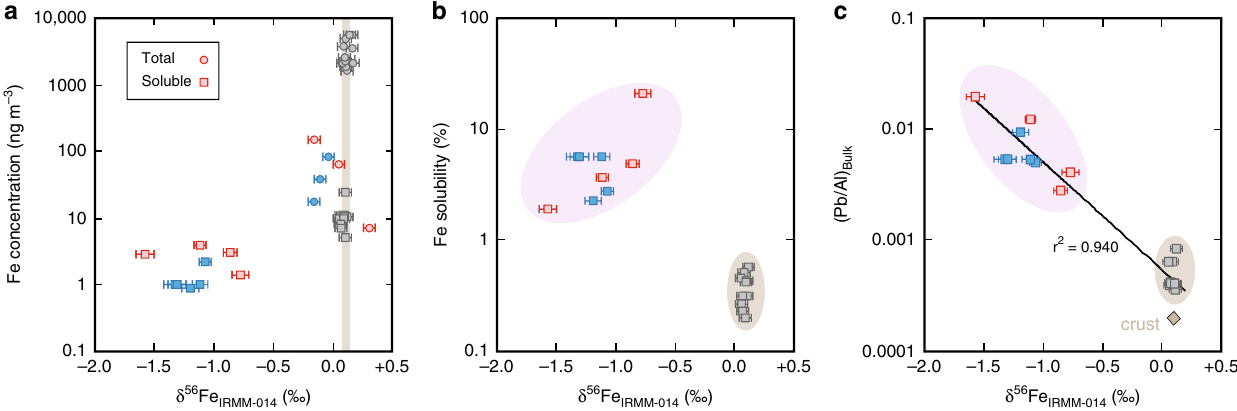
Fig. 2 North Atlantic GA03 aerosol Fe isotope results. Water-soluble and bulk aerosol δ 56 Fe relative to a Fe concentration 43 , b Fe solubility 44,45,58 , or c bulk Pb/Al 43 . Aerosols from different air masses 43 are separated by color: gray Saharan (2010 and 2011), red European (2010), and blue North American (2011). Error bars on δ 56 Fe are 2 σ external error (0.05 ‰ ) or 2 σ internal error (where larger). The brown vertical bar represents the δ 56 Fe signature of crustal source materials (0.07 – 0.14 ‰ ) 32 . Circles denote natural crustal (brown) or anthropogenic-sourced (purple) aerosol fi elds, based on this study. (Pb/Al) Bulk and the crustal diamond in ( c ) are based on other sources 36,43,48